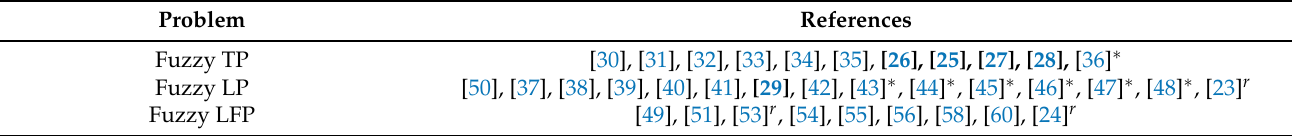
Table 3. A summary of the surveyed papers (the symbol r marks the review papers, the symbol ∗ marks the papers that need further investigations, and the references written in bold strictly comply to the extension principle).